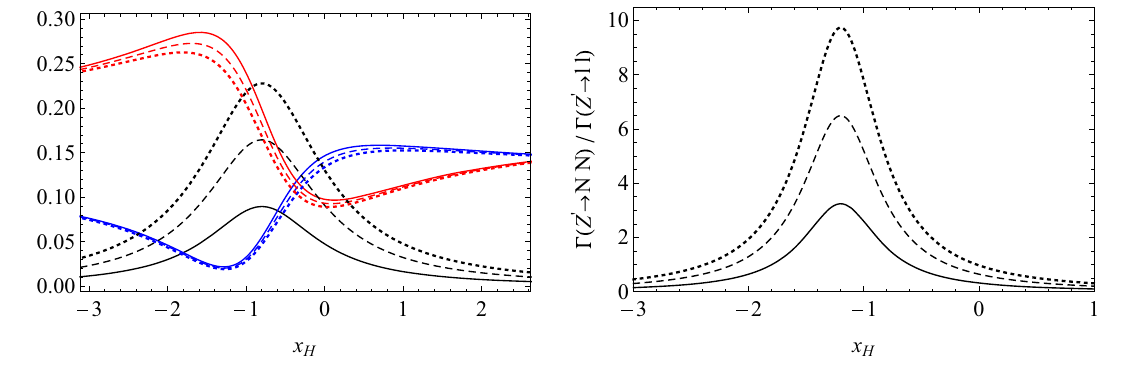
(up and down quarks), RHNs, and charged leptons, respectively. The lines for the RHN final states correspond to the sum of the branching ratio to all possible RHNs. In the right panel, we show the ratio of the partial decay widths of Z (cid:2) boson into RHNs and dilepton final states. The line codings are the same as in the left panel